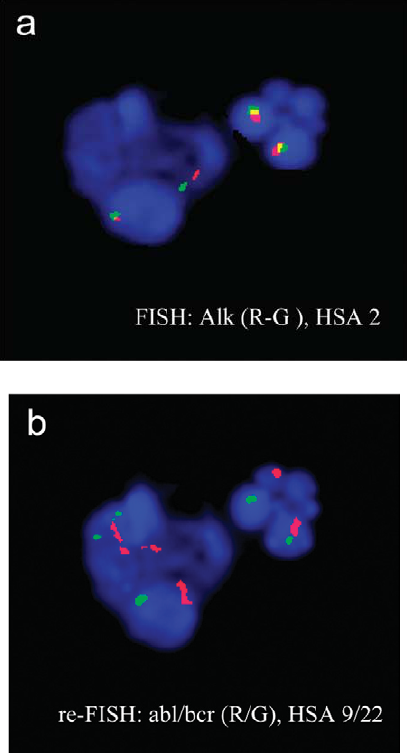
Fig. 2. A biphasic nucleus stained sequentially with dual colour FISH probe ALK in panel (a) and a probe combination of abl (red) and bcr (green) in panel (b), representing chromosomes HSA 2, 9 and 22. Signals are equitably distributed in the two chromatin ar- eas. Signals in the non-condensed area are elongated. (Accompany- ing nucleus of a polymorphonuclear cell (PMN) serve as a reference for size, morphology, etc.)